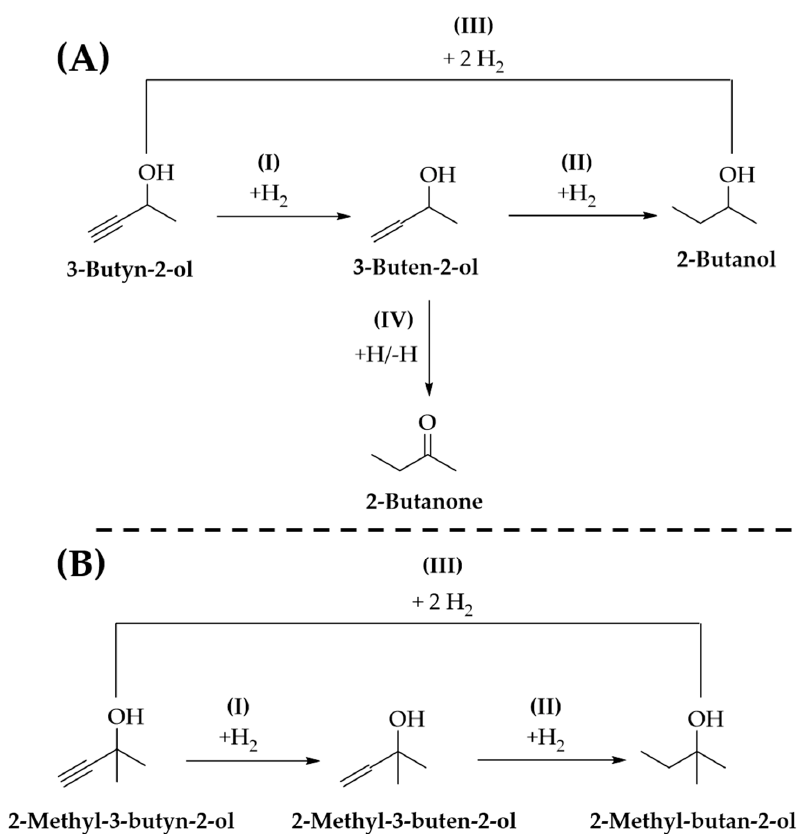
Figure 5. Reaction schemes for the hydrogenation of ( A ) secondary (3-butyn-2-ol) and ( B ) tertiary (2-methyl-3-butyn-2-ol) alkynols.